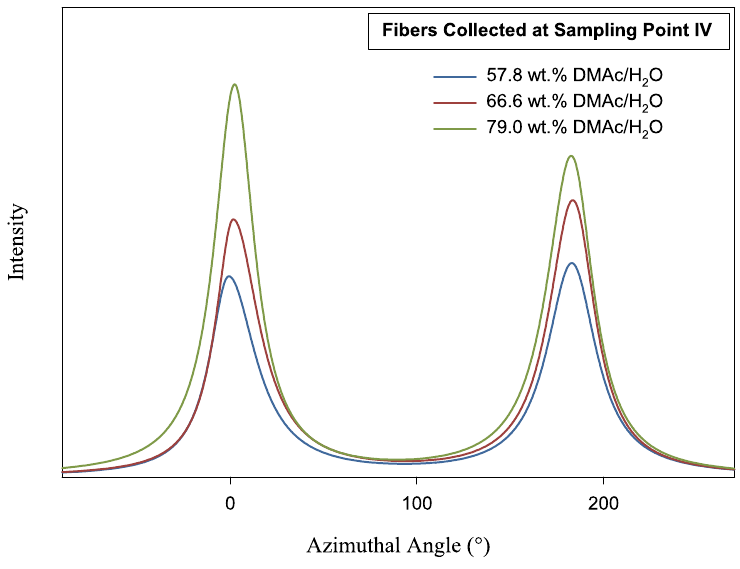
Figure 10. Azimuthal scan of as-spun fiber at 2 16.9    . Fibers were spun into varying composition coagulation